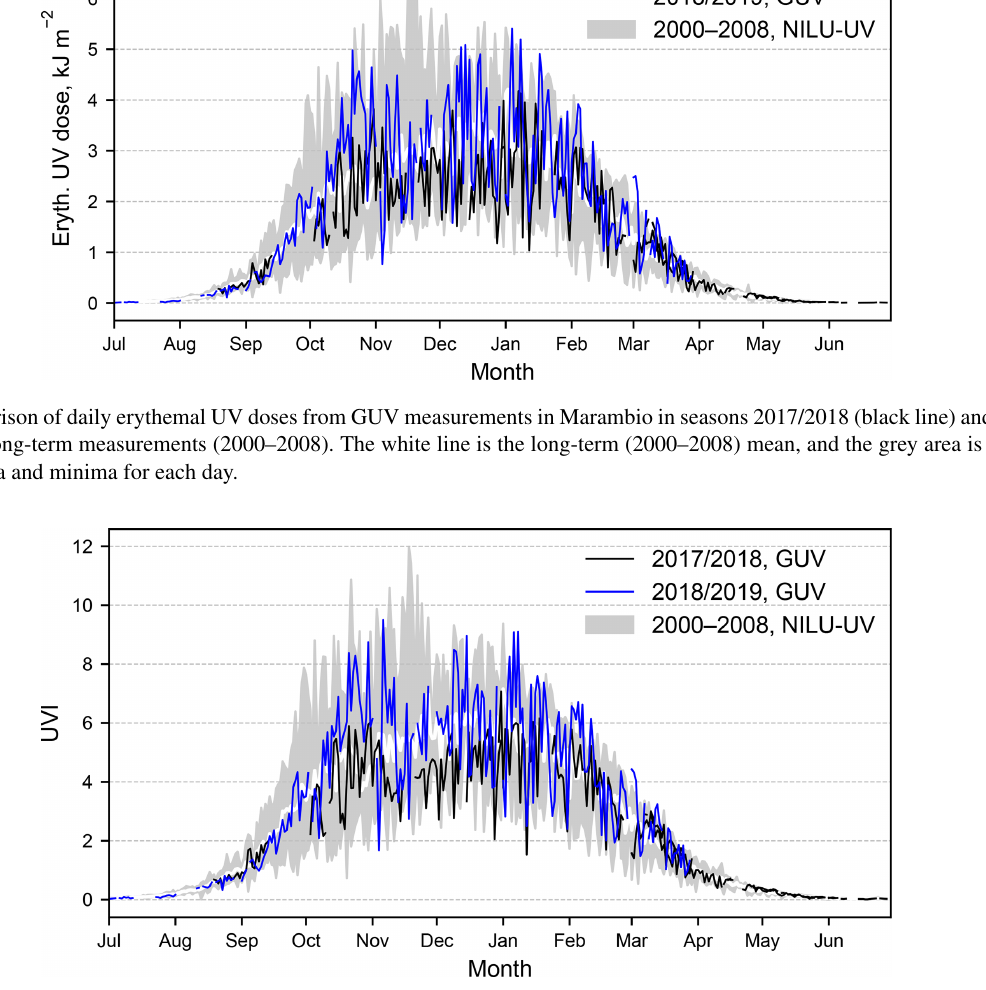
Figure 8. Comparison of daily maximum UVI from GUV measurements in Marambio in the seasons 2017/2018 (black line) and 2018/2019 (blue line) with long-term measurements (2000–2008). The white line is the historical mean (2000–2008), and the grey area is set between historic maxima and minima of maximum UVI for each